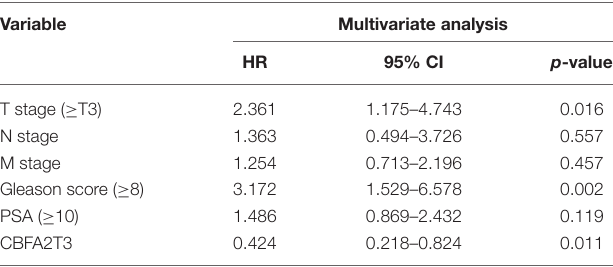
TABLE 2 | Multivariate analysis of CBFA2T3 CNV and patient survival.